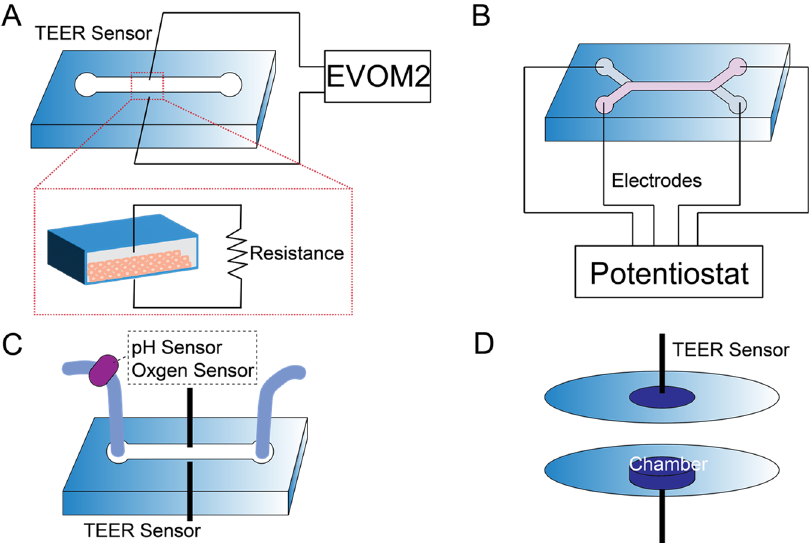
Figure 4. Sensor integration into kidney-on-a-chip with schematics of TEER measurement using ( A ) EVOM2 instrument and ( B ) four terminal sensing techniques using a potentiostat. TEER sensor measures the resistance across the cell layer. ( C ) Multiple sensors, such as pH and oxygen sensors, are integrated into microfluidic device with TEER measurements. ( D ) Bioreactors with small chambers are integrated with TEER